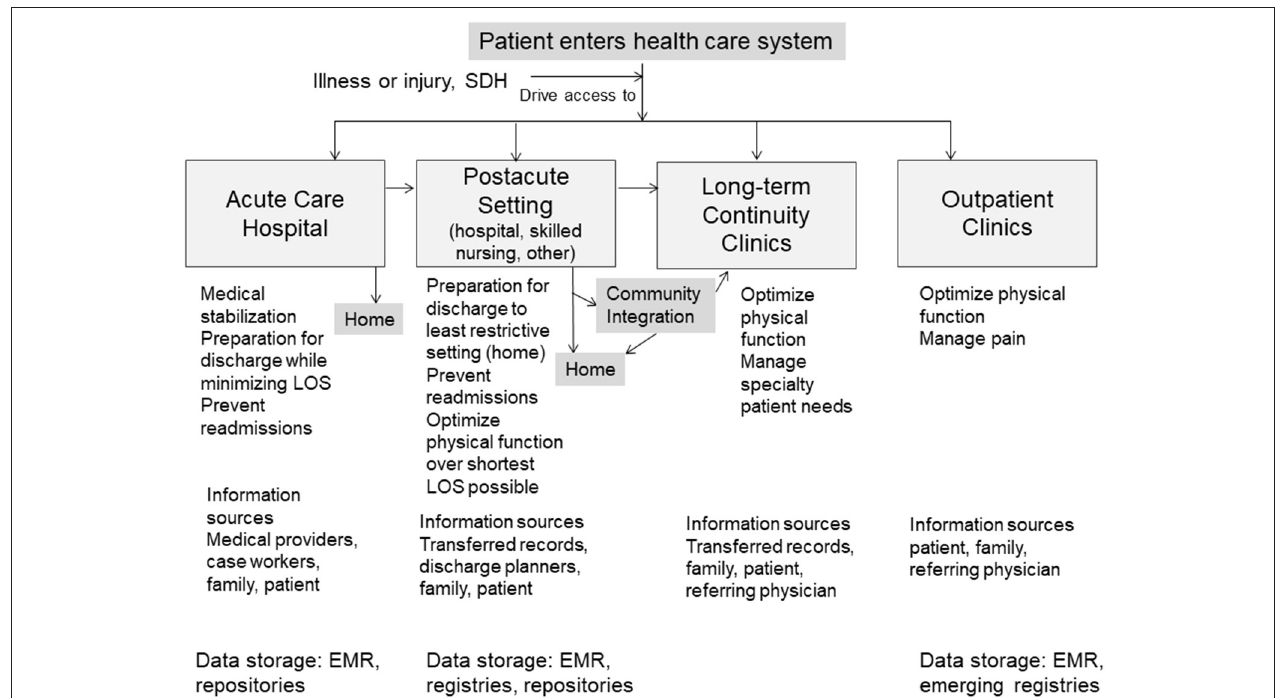
FIGURE 1 | Overview of possible patient pathways through the spectrum of physiatric care and variation of medical data sources and SDH captured and stored across rehabilitation